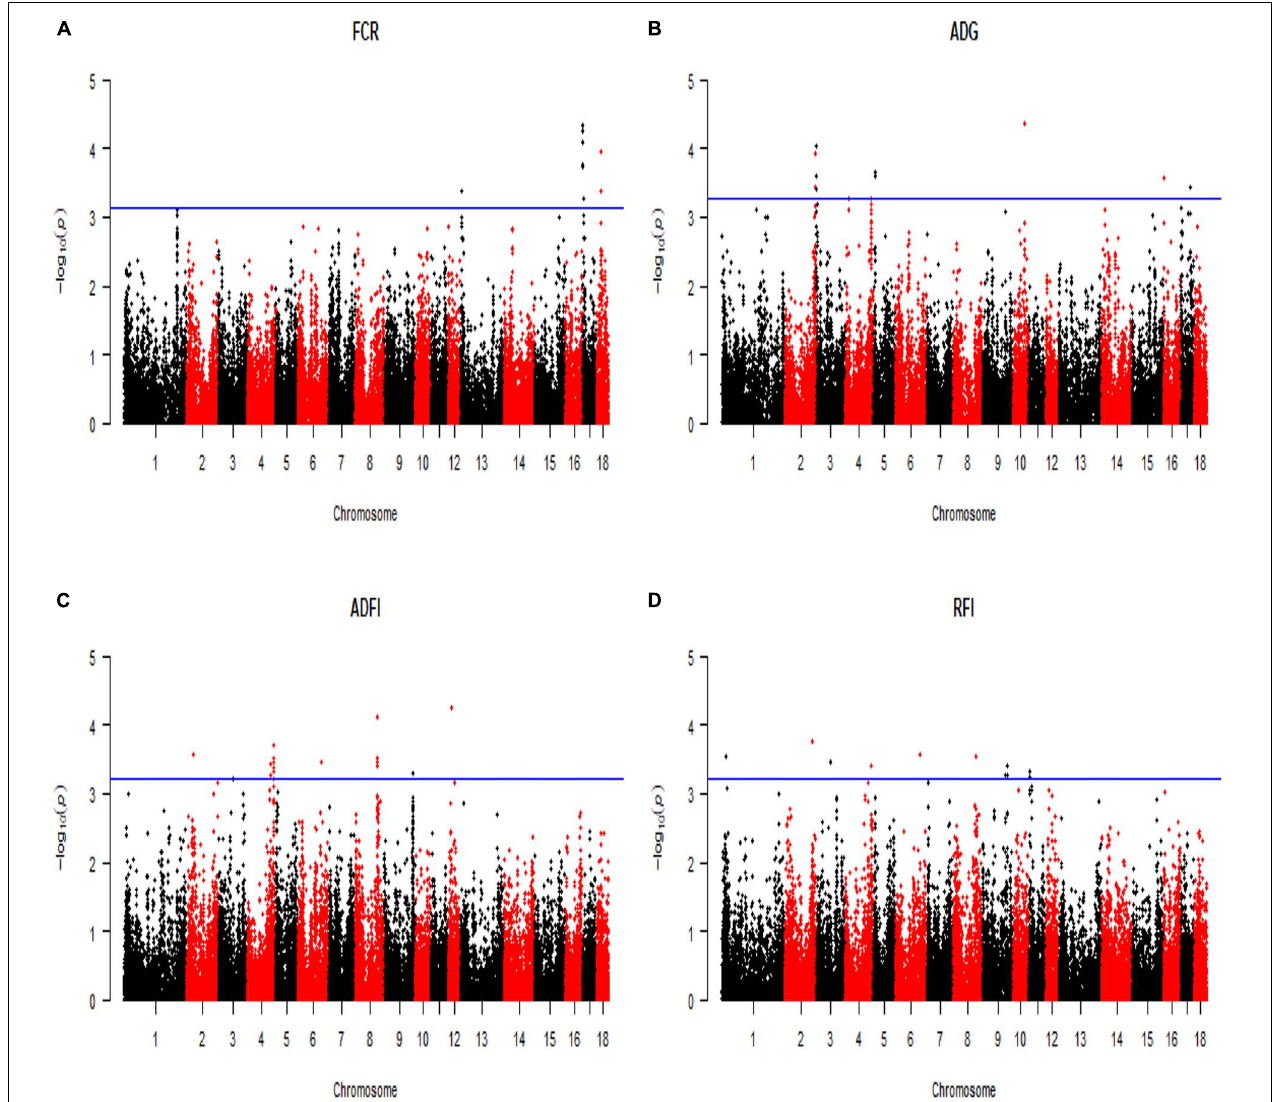
FIGURE 3 | Manhattan plot of the genome-wide association analysis on four feed efficiency traits by using single-step GWAS (ssGWAS) method. FCR, Feed conversion ratio; ADG, Average daily gain; ADFI, Average daily feed intake; RFI, Residual feed intake. In the Manhattan plots, negative log10 P- values of the quantified SNPs were plotted against their genomic positions. The x -axis and the y -axis represent the number of chromosome and the observed -log 10 ( P -value), respectively. Different colors indicate various chromosomes. The blue lines indicate the genome-wide significant thresholds of FDR adjusted, respectively. For (A) FCR, it was 7.17 × 10 − 4 . Similarly, (B) ADG was 5.52 × 10 − 4 , (C) ADFI was 6.16 × 10 − 4 , and (D) RFI was 5.89 × 10 − 4